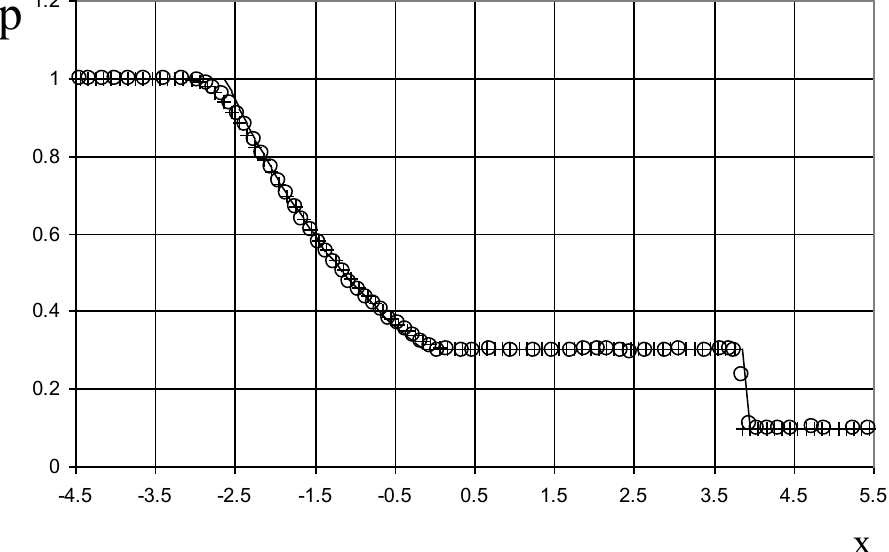
Figure 13. Pressure plot for the shock-tube problem of Sod: the exact solution (line), the ULT1C scheme of Harten (circle), and the present method (cross).